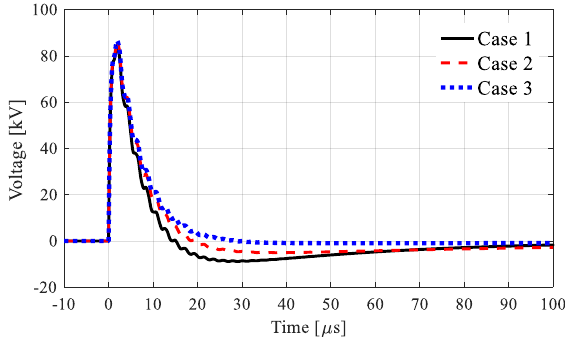
Figure 12. Generated waveforms by the conventional circuit.